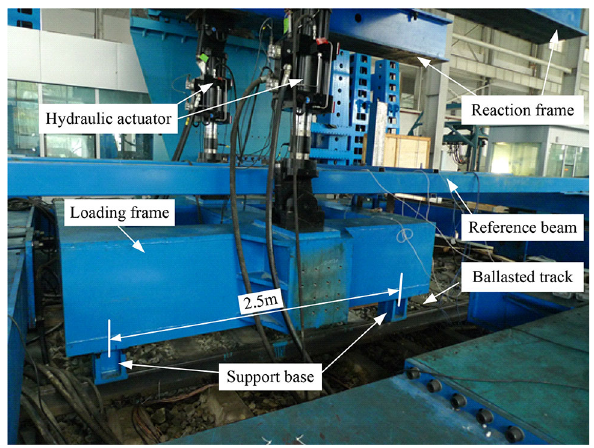
Fig. 21 Long-term service test of ballasted track–subgrade